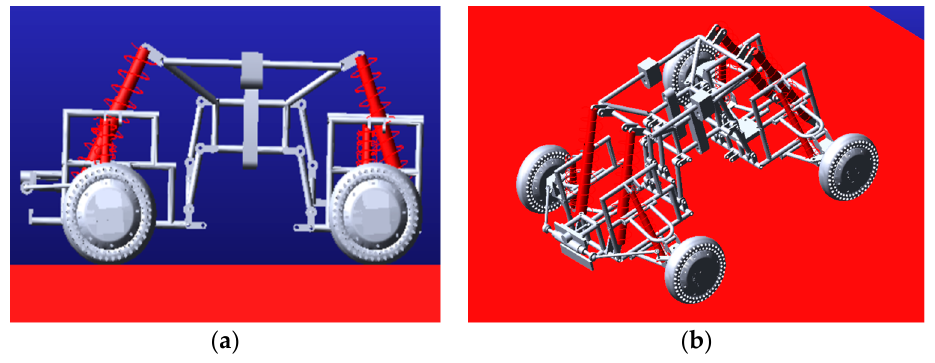
Figure 3. The vehicle model was imported into Adams. ( a ) is front view, ( b ) is oblique view, easy to observe the structure of the vehicle.